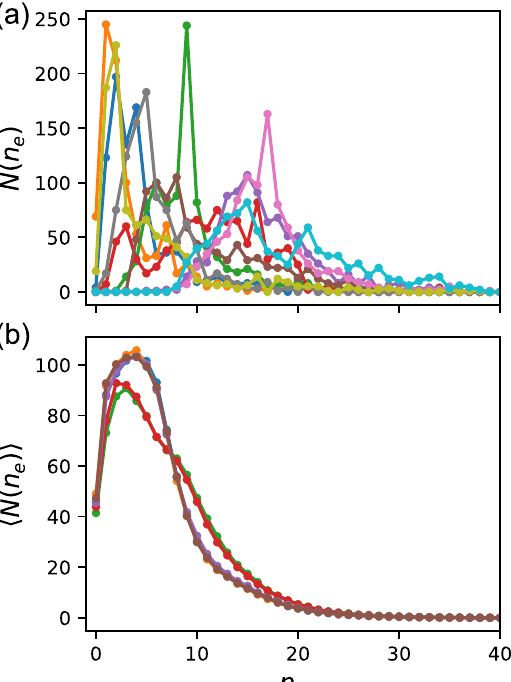
Fig 9. Distribution of the number of essential edges n for GRNs with f = 0.99. We introduced the upper limit of e 0.99 for fitness, and conducted Evo90. In other words, a fitness larger than 0.99 was regarded as f = 0.99. The data for all GRNs with f = 0.99 for each population were used. (a) Distribution of n at the generation where the fitness of all the e preserved GRNs first reached 0.99. The results of ten independent runs are shown. (b) Average distribution of n e in the steady state. After 2000 generations, we collected GRNs at every 2000 generations up to one million generations and took their average. The results of six independent runs are shown.